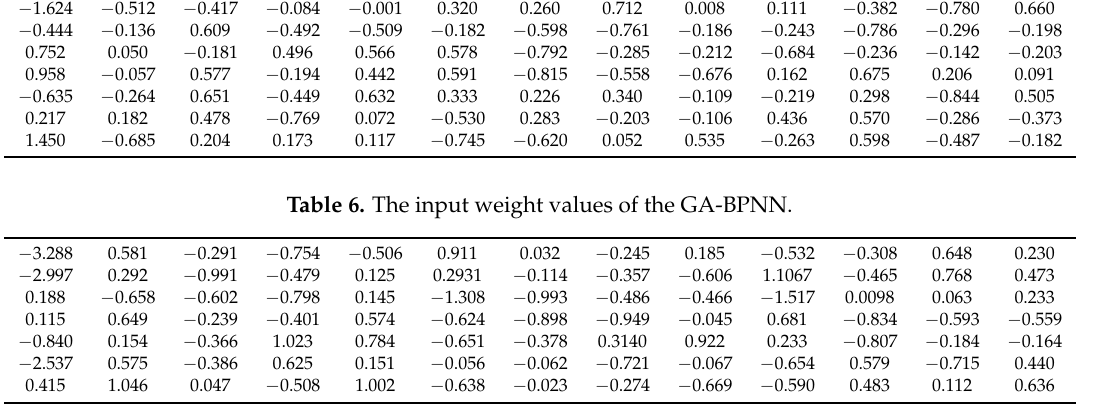
the prediction data with the simulation data, the comparison results are shown in Figure 8. It can be seen from Figure 8 that both BPNN and GA-BPNN have a high accuracy to predict the strain, and that the GA-BPNN had a smaller